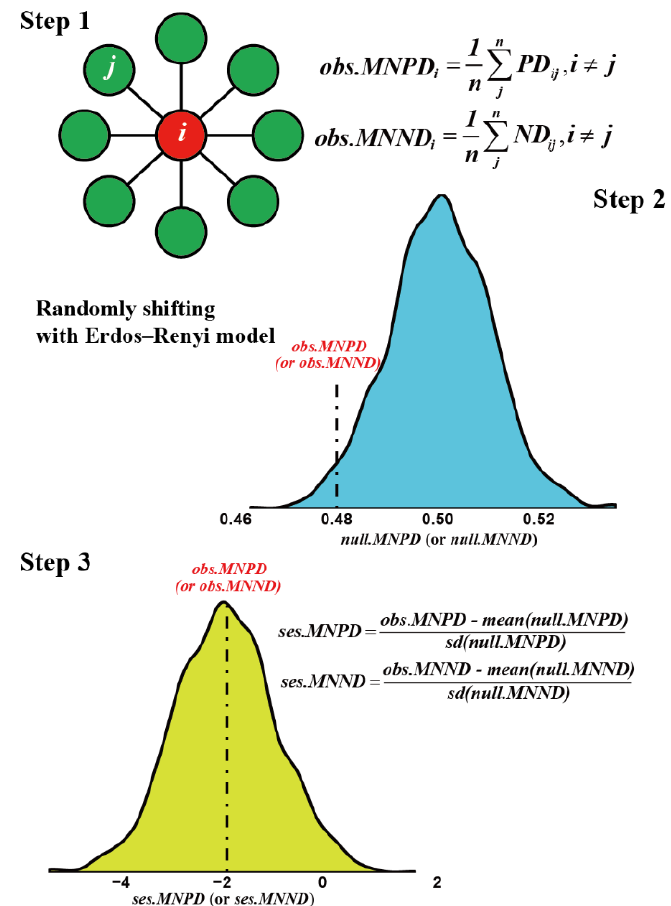
Figure 1. The flowchart of the summarizing procedure for estimating mean neighbor phylogeny and niche distance ( MNPD and MNND ) at node level. First, the observed MNPD and MNND ( obs.MNPD and obs.MNND ) were quantified based on empirical networks. Second, the links of empirical networks were randomly shifting with the Erdos–Renyi model, and null distributions of MNPD and MNND ( null.MNPD and null.MNND ) were generated. Third, the standardized effect sizes of MNPD and MNND ( ses.MNPD and ses.MNND ) were calculated based on observed and null values. The absolute values of ses.MNPD ( ses.MNND ) larger than two show statistical significance (two sides, p < 0.05).